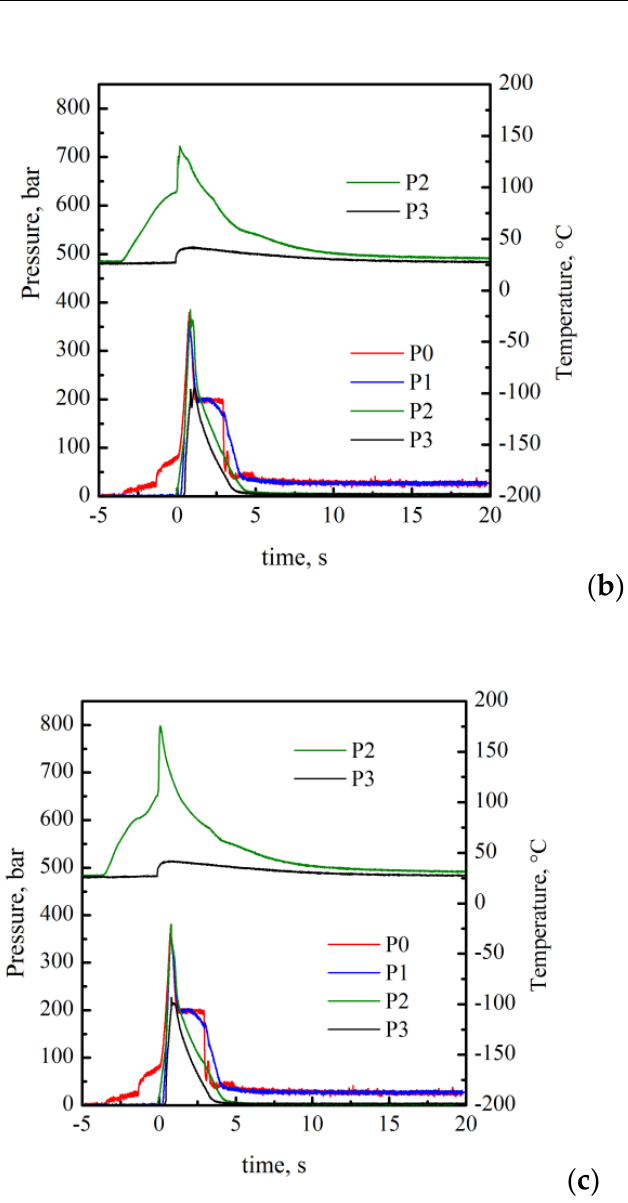
Figure 3. Pressure evolutions recorded in three different positions along the flow path, P0, P2, and P3, and temperature evolutions recorded in positions P2 and P3, where the heater is located, and position P3, where the heater is not present. Three cases are shown: ( a ) conventional injection molding condition, ( b ) 40 W heating power, and ( c ) 68 W heating power.